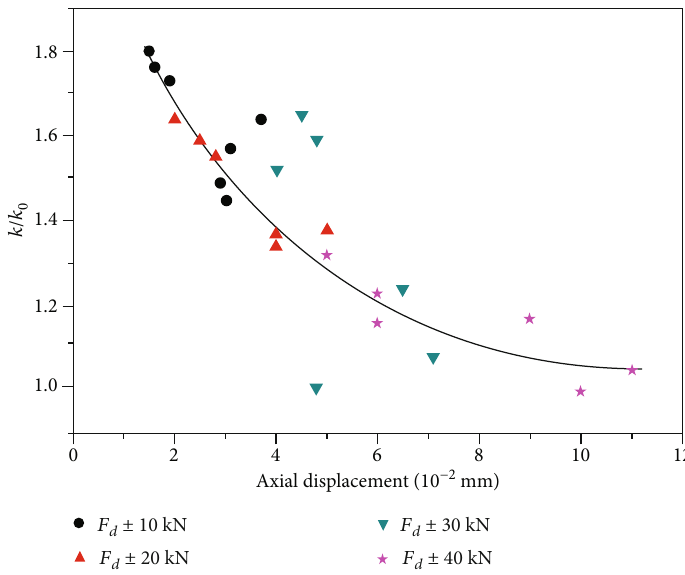
Figure 7: Permeability evolution of fracture with axial displacement in di ff erent amplitudes of dynamic axial force.